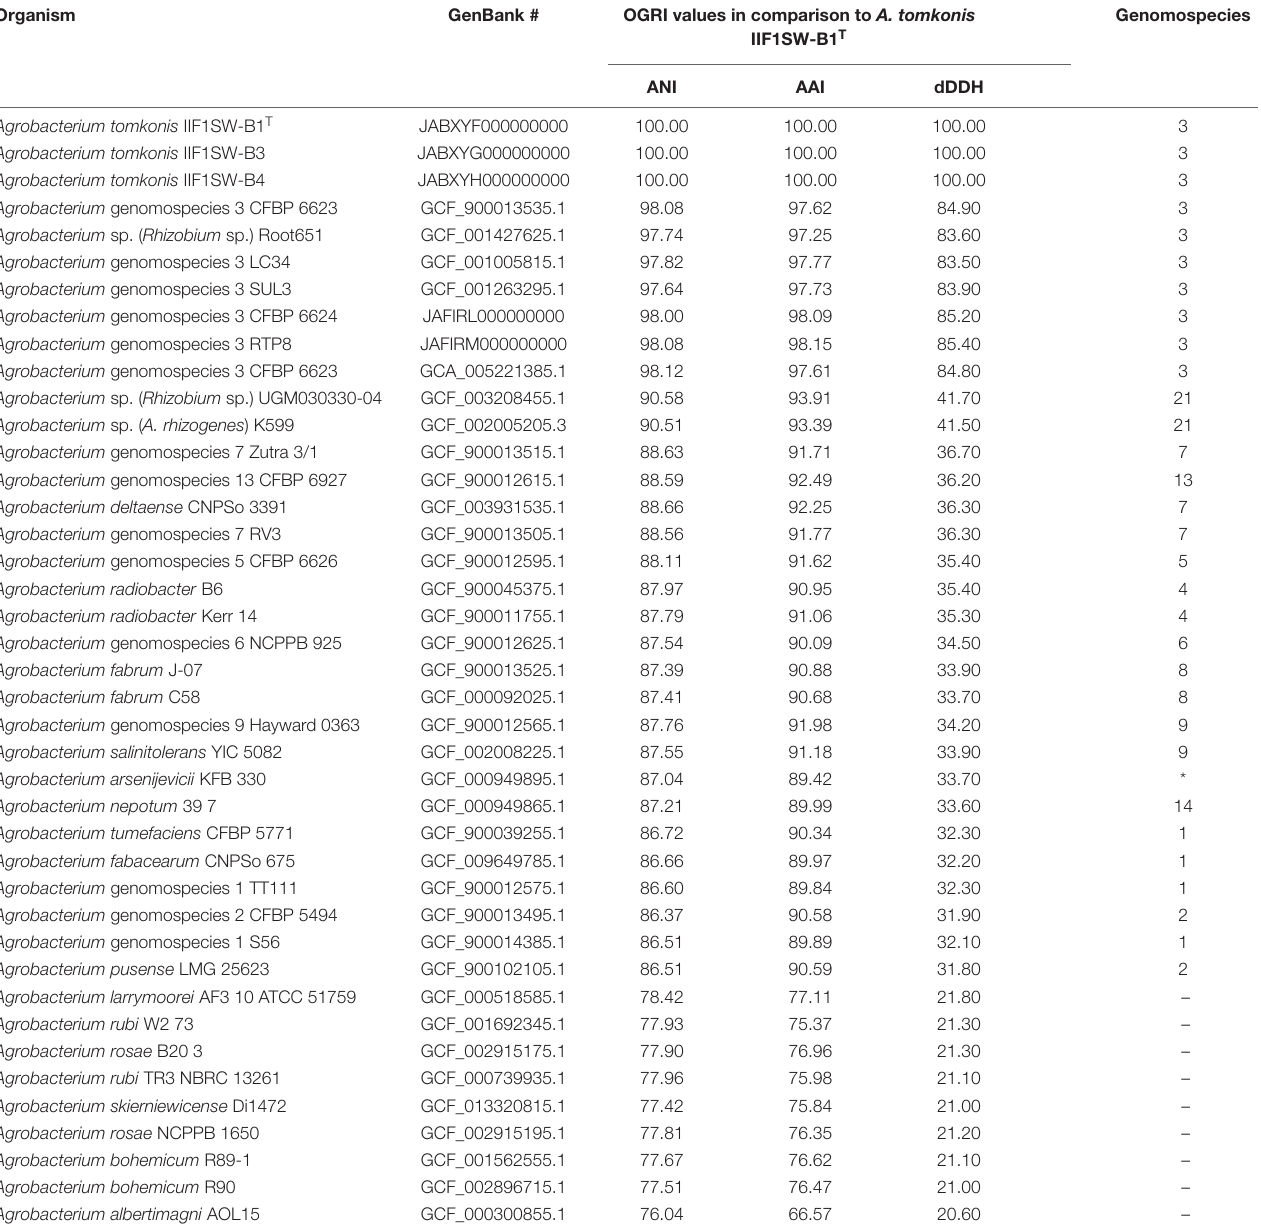
TABLE 2 | List of Agrobacterium genomes used in this study and Average Nucleotide Identity (ANI), Average Amino acid Identity (AAI), and digital DNA-DNA Hybridization (dDDH) values of A. tomkonis IIF1SW-B1 T compared with all other tested Agrobacterium strains. Organism GenBank